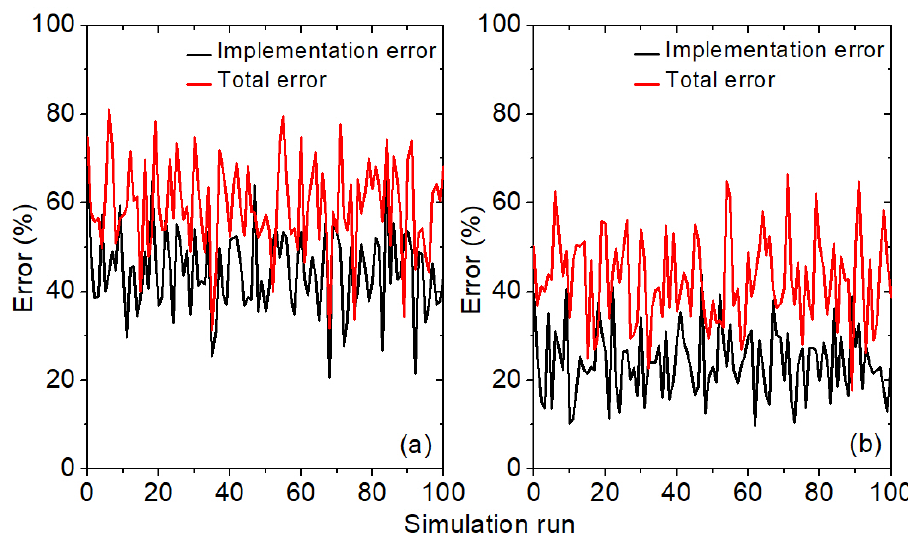
Figure 8. Total error (red lines) and Implementation error (black lines) for the 100 Monte Carlo simulations in Figure 7 when using the non-optimized ( a ) and the optimized ( b ) set of M-ISVPA programming parameters.